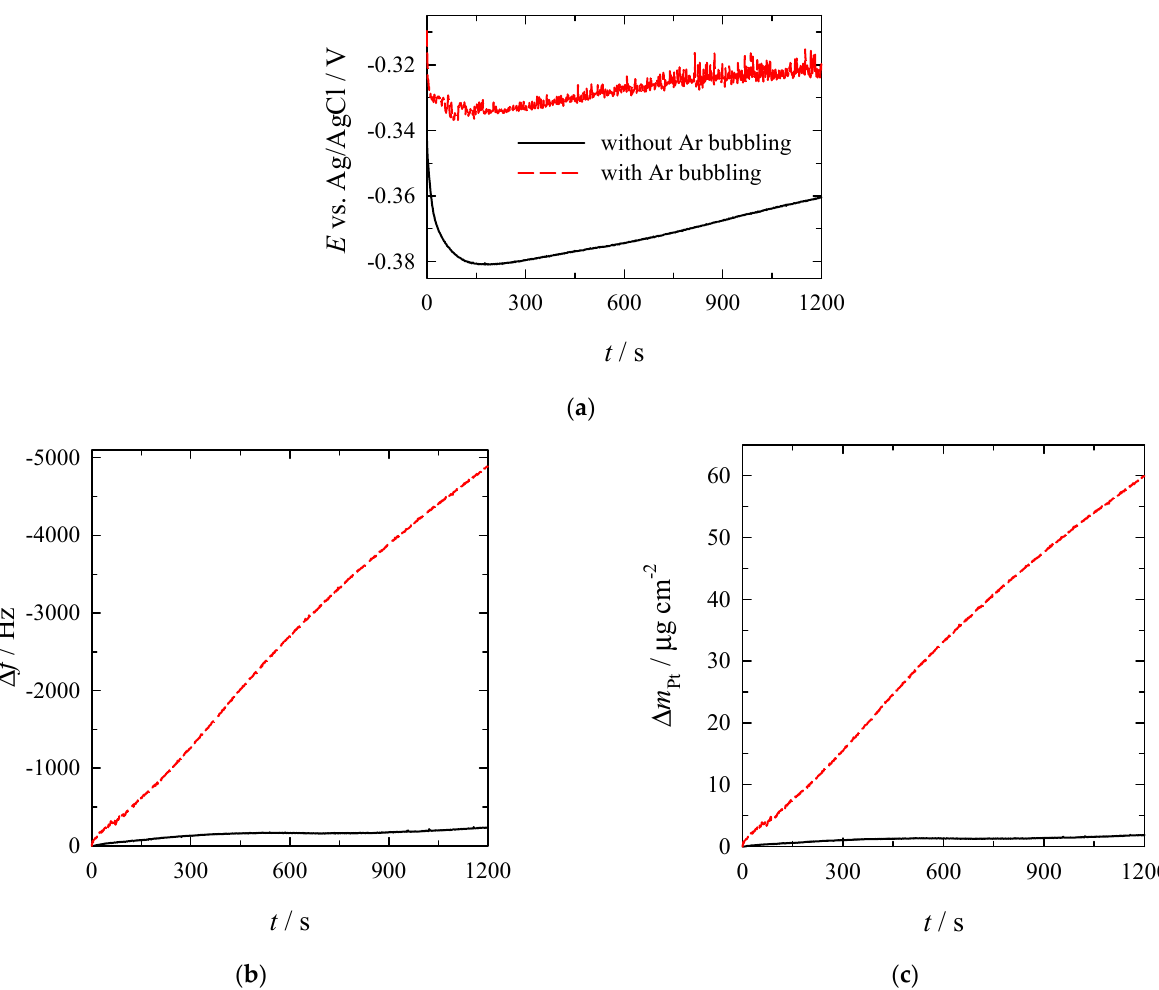
Figure 9. Kinetics of electroless platinum plating under conditions with Ar bubbling (dashed line) and deaerated and not-agitated solution (solid line) under stationary conditions: open-circuit potential ( a ), change in frequency ( b ) and platinum mass gain ( c ). Solution contained (mol L − 1 ): H 2 PtCl 6 —0.004; NH 4 OH—0.4; complexing agent—0.16; CoCl 2 —0.2; HCl to pH = 7.5; 20 ° C.